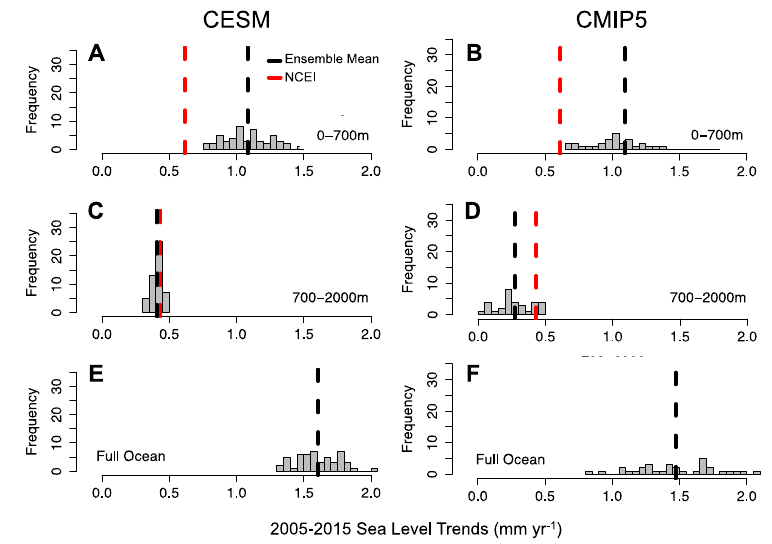
Figure 6. Histograms of model ensemble steric trends over different depths for the decadal period (2005–2015). Full ocean is defined as the entire available depth of each model ocean. Red dashed lines are observations from NCEI, and black dashed lines are the model ensemble means. ( A ): CESM, 0–700 m; ( B ): CMIP5, 0–700 m; ( C ): CESM, 700–2000 m; ( D ): CMIP5, 700–2000 m; ( E ): CESM, Full ocean; ( F ): CMIP5, Full ocean.